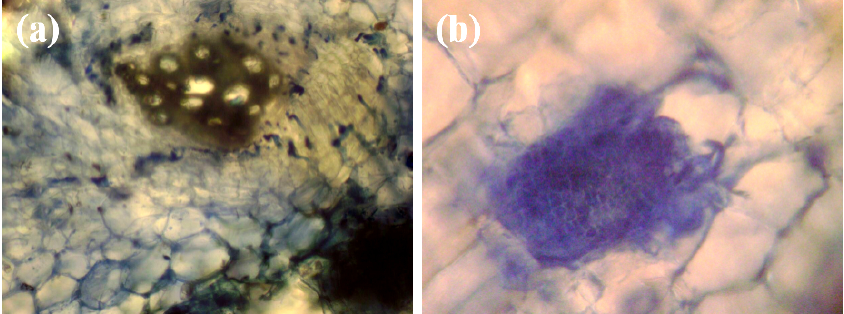
Figure 2. Cross section of cucumber root tissue affected by P. melonis 502. ( a ) Tiloses formed on the inner surface of xylem vessels, 200× magnification. ( b ) Microsclerotia of P. melonis in root tissues of cucumber plants, 400× magnification.